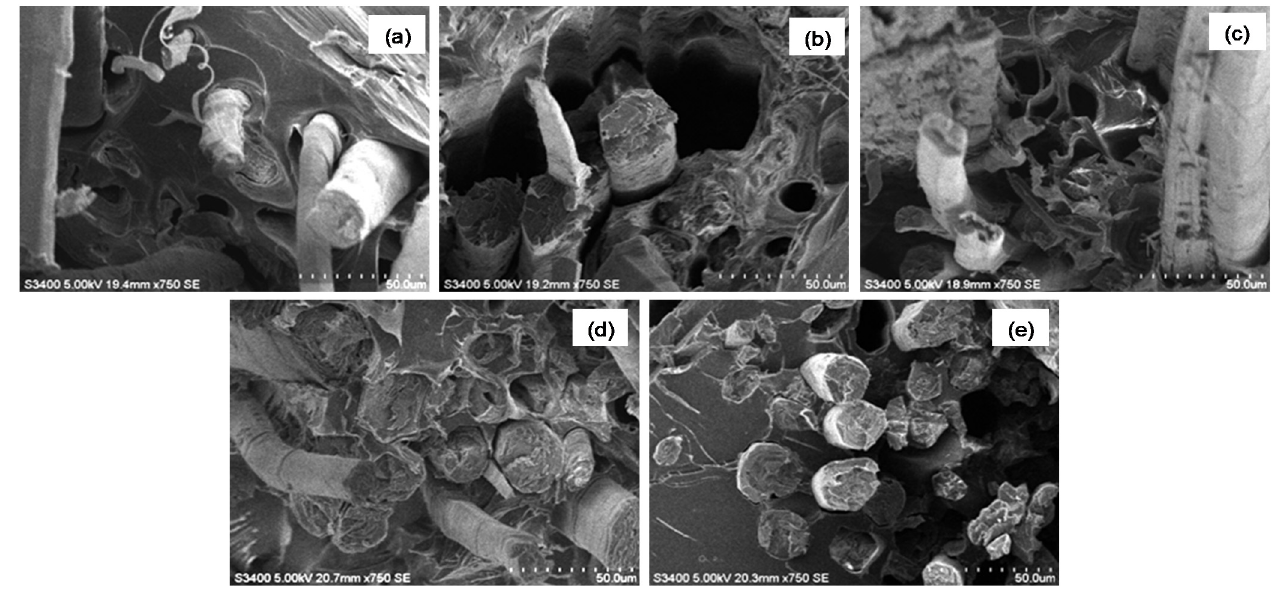
Figure 10. SEM images of the fracture surfaces of ( a ) Flax/PLA, ( b ) FR-Flax-PLA, ( c ) FR-Si-Flax/PLA, ( d ) FR-Pm-Flax/PLA, and ( e ) FR-Pm-Si-Flax/PLA 8-layered laminates. ( d ) FR-Pm-Flax/PLA, and ( e ) FR-Pm-Si-Flax/PLA 8-layered